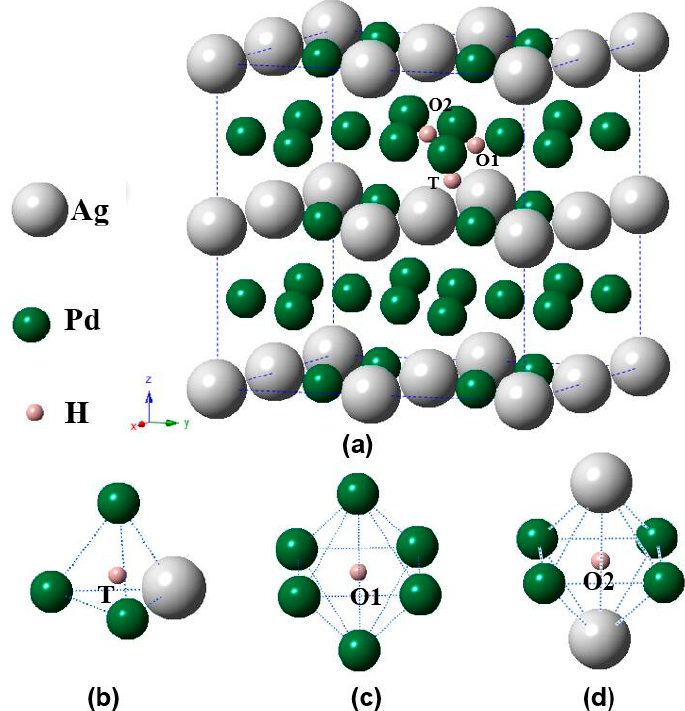
Figure 1. Schematic illustrations of ( a ) various interstitial sites of the Pd 3 Ag phase, ( b ) tetrahedral (T) site, ( c ) octahedral (O1) site, and ( d ) octahedral (O2) site.